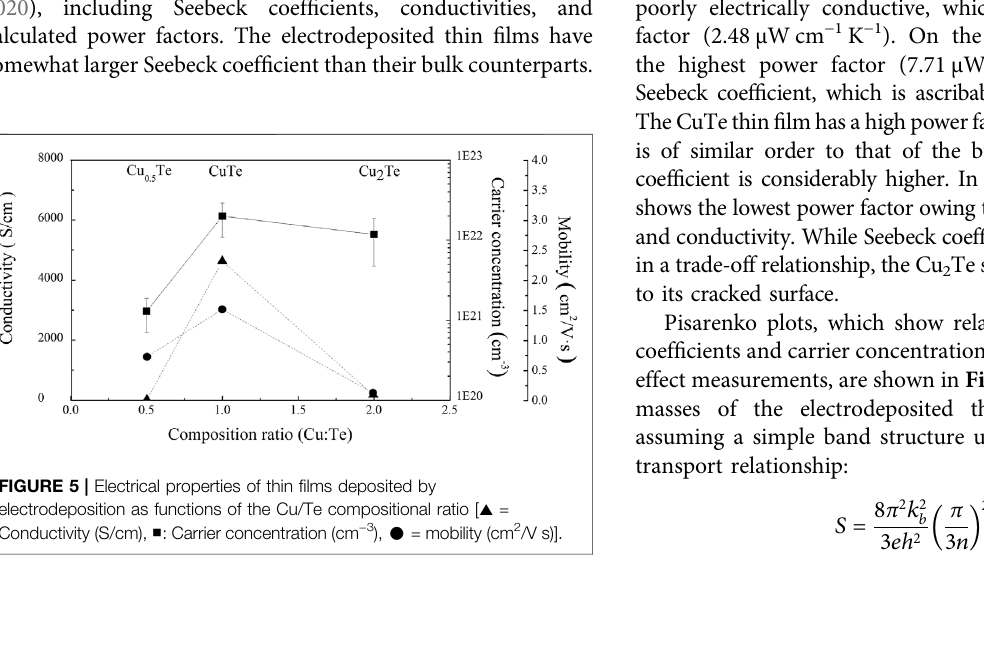
TABLE 1 | Thermoelectric properties of copper tellurides determined by Hall-effect measurement (this work) and the S measurement system at room temperature. Compositional ratio